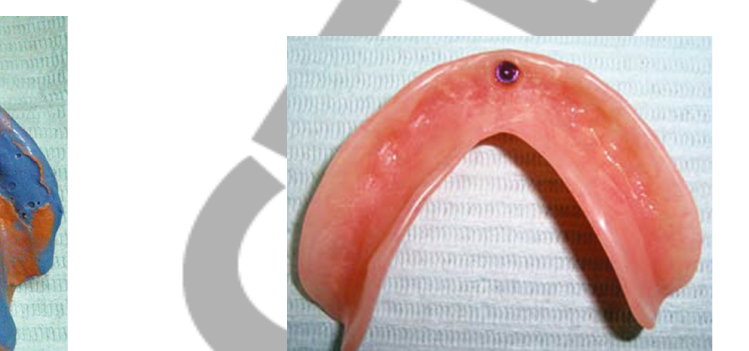
Figure 4: Titanium matrix over the retentive anchor to be in- corporated in the finished denture.